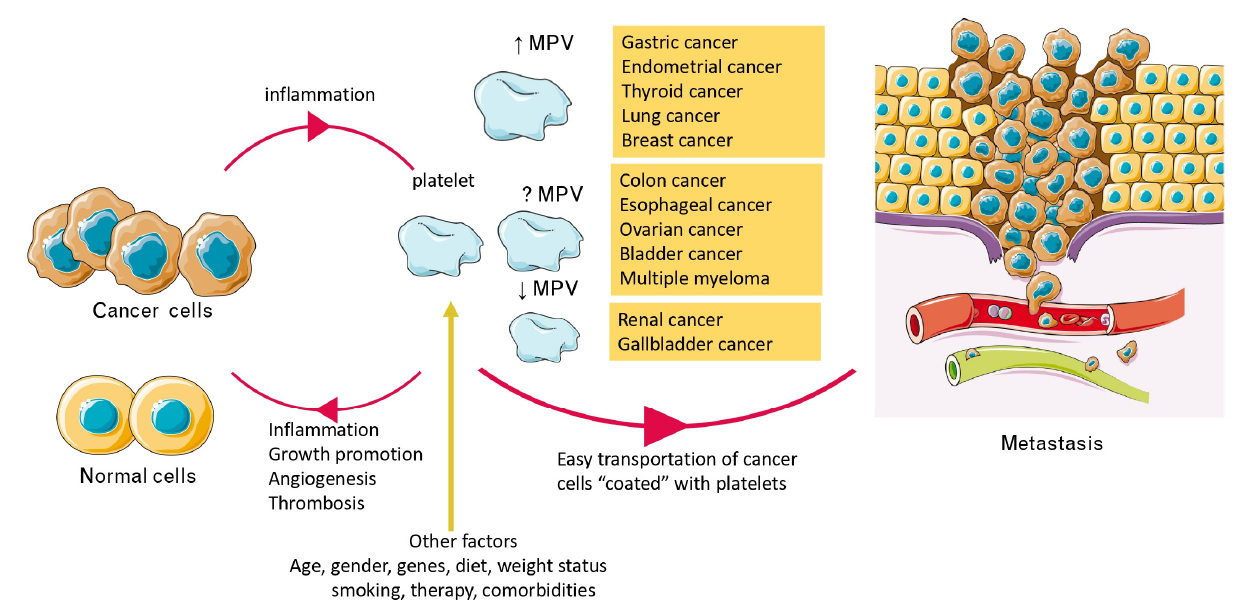
Figure 2. The bidirectional relation of cancer and MPV. Parts of the figure were drawn using pictures from Servier Medical Art. Servier Medical Art by Servier is licensed under a Creative Commons Attribution 3.0 Unported License (https://creativecommons.org/licenses/by/3.0/, accessed on 13 March 2023).